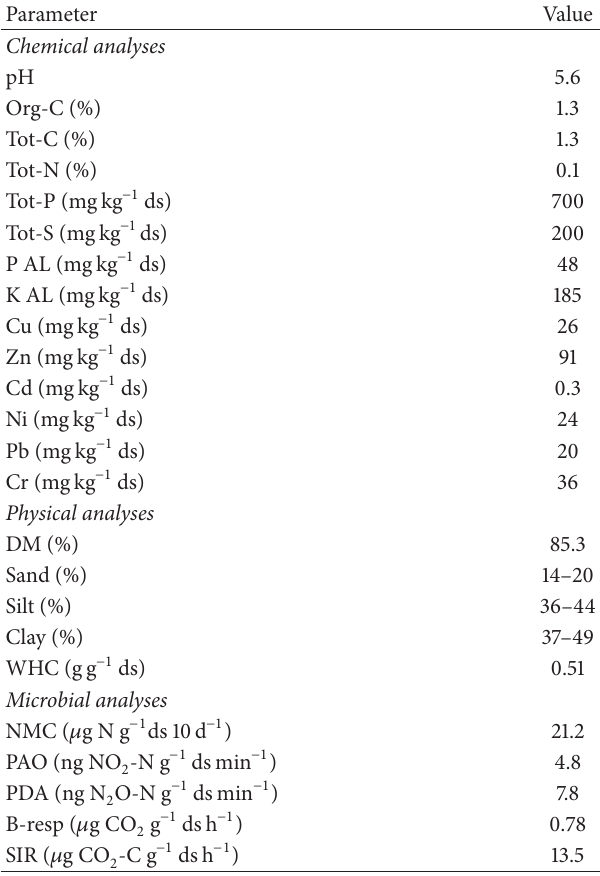
Table 1: Chemical, physical, and microbiological characteristics of the soil used in the experiment